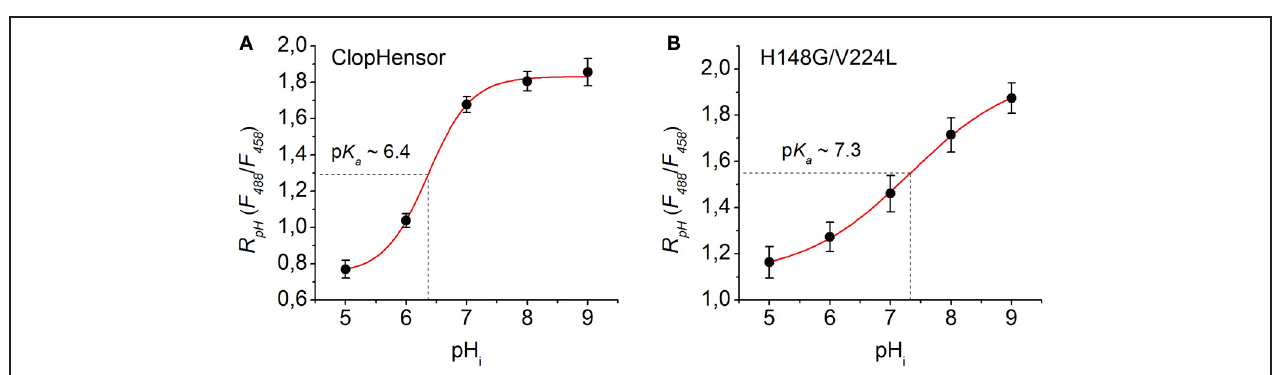
FIGURE 7 | Calibration of ClopHensor and H148G/V224L mutant for pH. (A) and (B) Changes in R pH ( F 488 / F 458 ) of ClopHensor (A) and H148G/V224L mutant (B) measured in transfected partially permeabilized CHO cells perfused with bath medium of different pH values (see Materials and Methods for details).